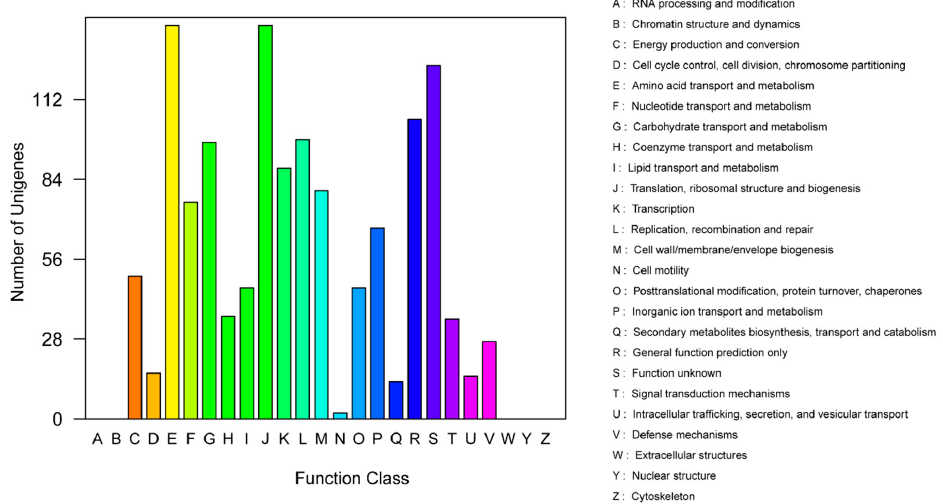
Figure 2. Clusters of orthologous groups (COG) annotation classification statistics of Leu. mesenteroides DRP105 genome.